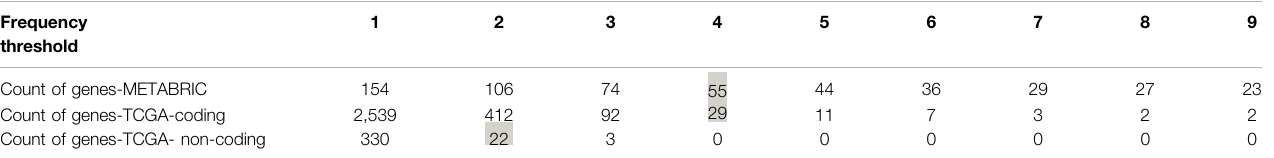
TABLE4| Numberofgenesaffectedperdifferentthresholds.Thethresholdsindicatethenumberofpositivesomaticpointmutationseachgeneisharboring.Thehighlighted ones were used in the gene level survial analysis. Frequency threshold